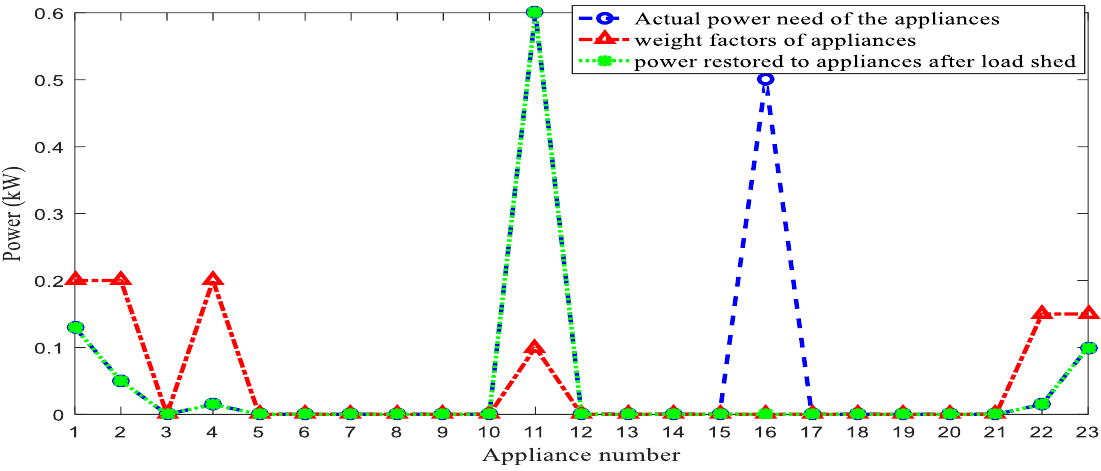
Figure 12. Actual load to meet, weight factors assigned for priority of appliance, and power restored due to EVs for residential user 6.